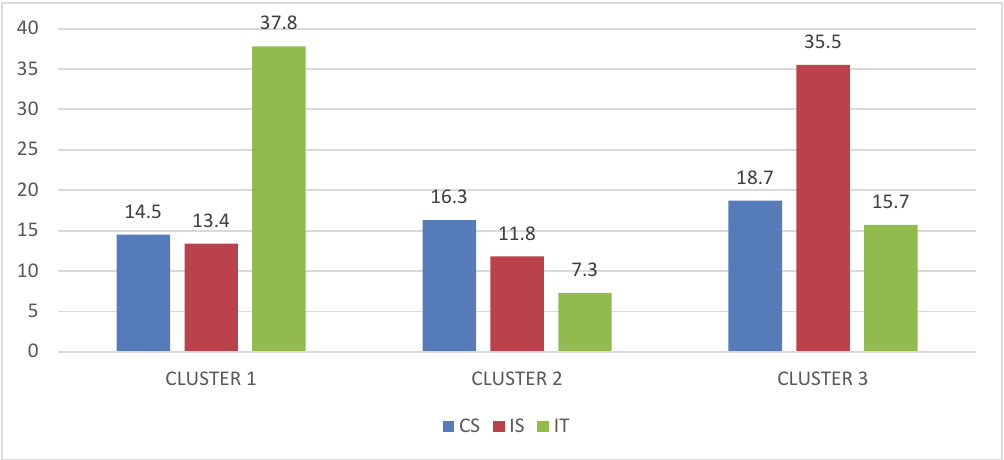
Fig. 1. Computing Department Tracks Among the Three